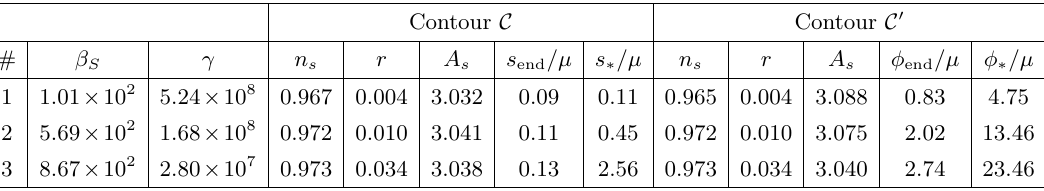
Table 1 . Parameters of the benchmark points marked in figure 1. For all points we have fixed λ Sσ = 0 . 77 , λ S = 0 . 005 and β σ = 1 i.e. the VEV in each case is v S = 0 . 088 µ . The last six columns show predictions of CMB observables and related field values by either using the inflaton potential along contour C or C 0 for N e = 55 e-folds. See appendix A for more details of the valley